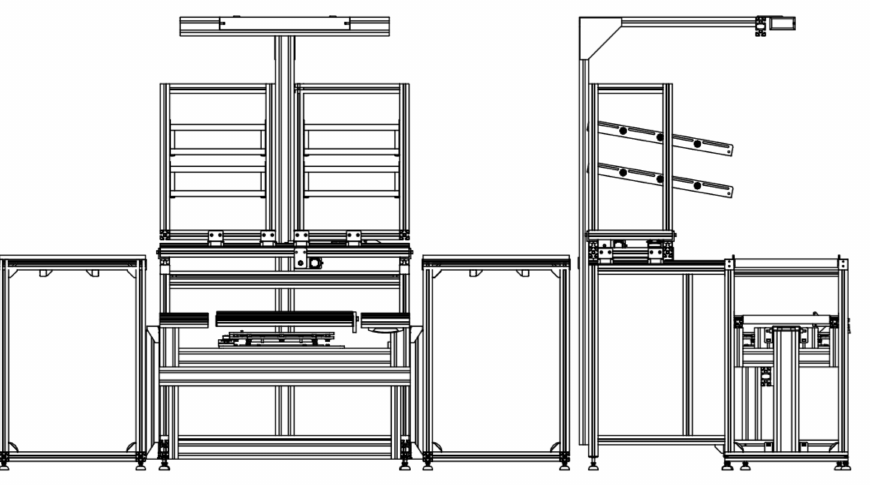
Figure 2. Front and lateral Computer Aided Design (CAD) model of the Self-Adaptive Smart Assembly System (SASAS) prototype